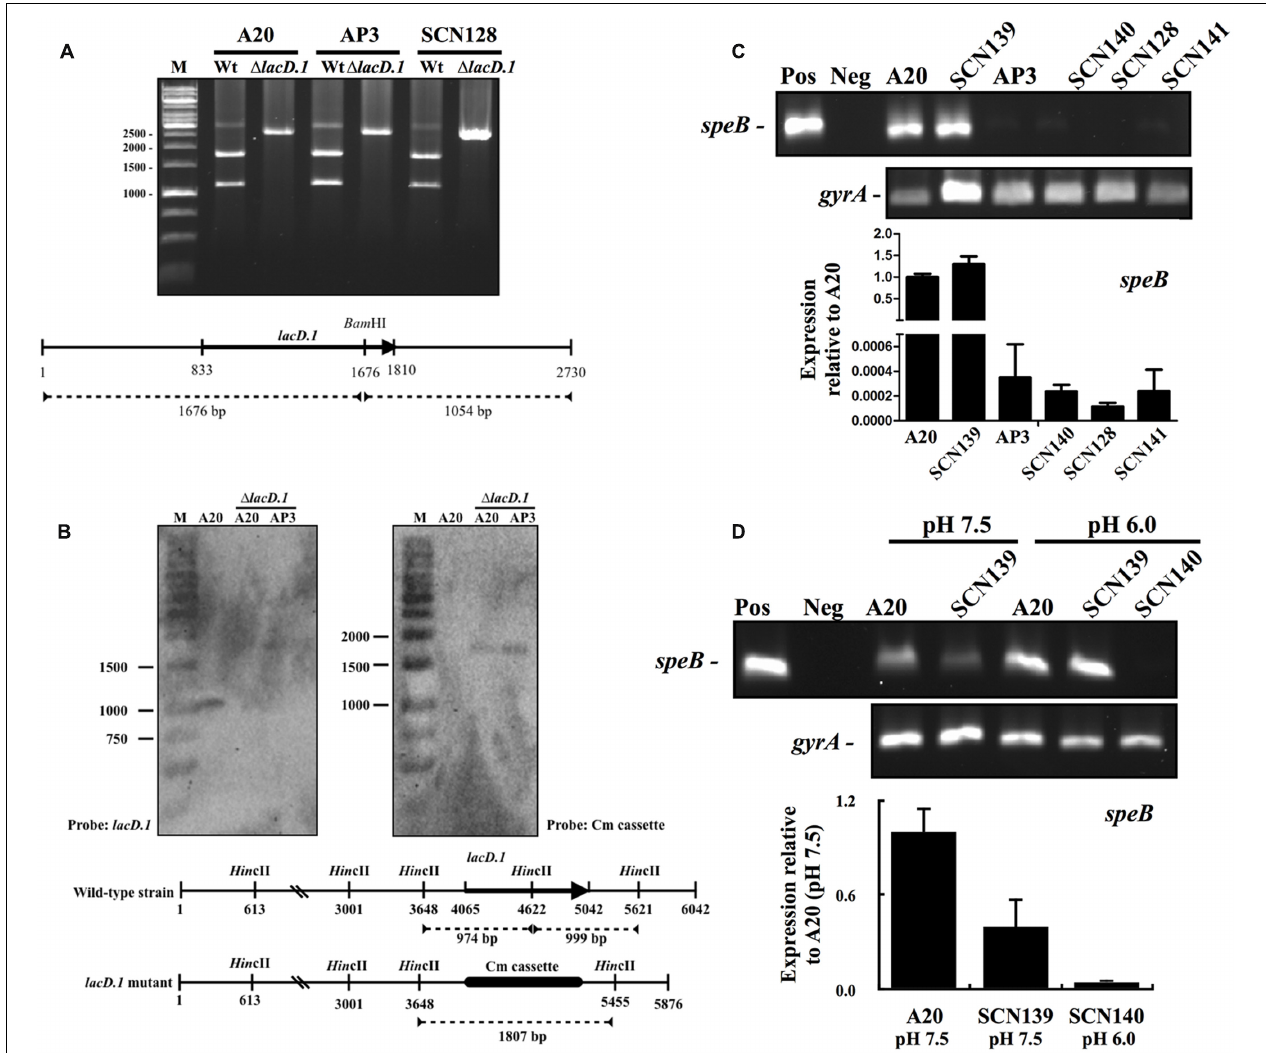
FIGURE 6 | The expression of speB in wild type A20 strain, covS mutant AP3, A20 CovR D53A mutation strain SCN128, and their isogenic lacD.1 mutants. Deletion of the lacD.1 gene in lacD.1 mutants was verified by restriction enzyme digestion and Southern blot analysis. (A) The Bam HI digestion pattern of the partial lac.1 operon in wild type strains and their isogenic lacD.1 mutants. The lower panel shows the location of the lacD.1 gene, Bam HI restriction enzyme sites, and predicted size after Bam HI digestion. M, DNA marker. (B) Southern blot analysis for A20, A20 lacD.1 mutant, and AP3 lacD.1 mutant. Genomic DNAs were digested by Hin cII and separated by 1% agarose gel for Southern blot analysis. The lower panel shows the location of the lacD.1 gene in wild type strains, a Cm cassette in lacD.1 mutants, Hin cII restriction enzyme sites, and the predicted size for lacD.1 and Cm probe hybridization. M, DNA marker. (C) The expression of speB in A20, AP3, SCN128, and their isogenic lacD.1 mutants (SCN139, SCN140, and SCN141, respectively). GAS strains were cultured in TSBY broth to the stationary phase of growth and RNAs were extracted for RT-PCR and qPCR (lower panel) analyses. (D) The expression of speB in A20, AP3, and their isogenic lacD.1 mutants at pH 7.5 and pH 6.0 conditions. GAS strains were cultured in neutral and acidic pH broths for 3 h and RNAs were extracted for RT-PCR analysis. The expression of gyrA gene is used as the internal control. Pos and Neg: Positive control (genomic DNA as template) and negative control. Lower panel, qPCR analysis for the speB expression in A20 and SCN139 under pH 7.5 condition and SCN140 under pH 6.0 condition. Biological replicate experiments were performed using three independent RNA preparations in duplicate. The expression of speB was normalized to the gyrA